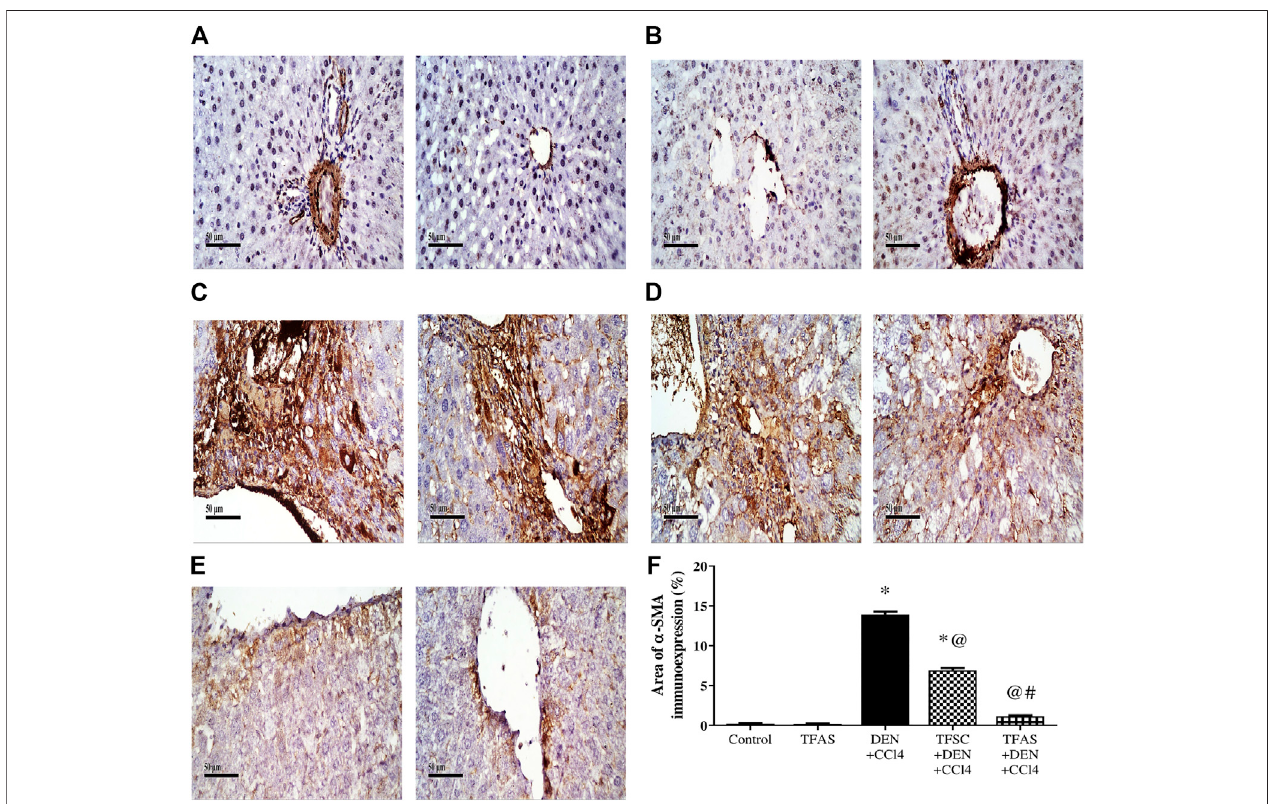
FIGURE 3 | Effect of TF-ODNs on liver α -SMA expression. Immune-stained liver section of α -SMA expression is detected in hepatic stellate cells, fi broblasts and vascular wall, (A) control group, (B) TFAS group, (C) DEN+CCl4 group, (D) TFSC+DEN+CCl4 group, (E) TFAS+DEN+CCl4 group and (F) The percentage of α -SMA expression. Data are expressed as mean ± SEM (n (cid:1) 8). (*), (@) and (#) indicate signi fi cant difference from Control, DEN+CCl4 and TFSC+DEN+CCl4, respectively at P < 0.05 using one-way ANOVA followed by Tukey-Kramer post-Hoc test. α -SMA: alpha smooth muscle actin; DEN: N-diethyl nitrosamine; CCl4: carbon tetrachloride; TFSC: scrambled tissue factor oligodeoxynucleotides; TFAS: antisense tissue factor